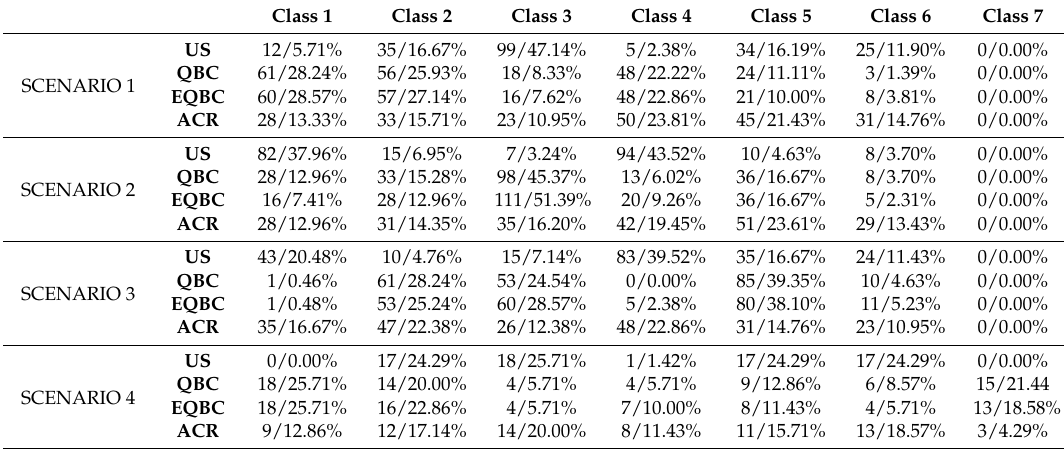
Table 2. Category distribution in Scenarios 1–4 (selected number/ratio).